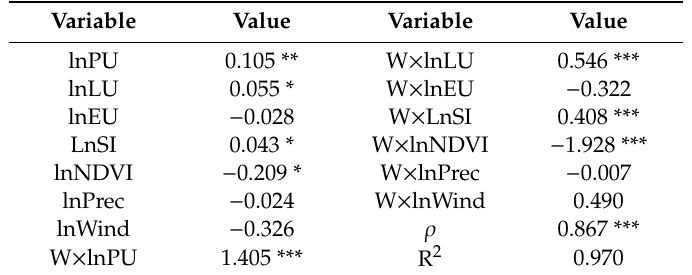
Table 6. Results of the SDM model under the spatial and time fixed e ff ects.